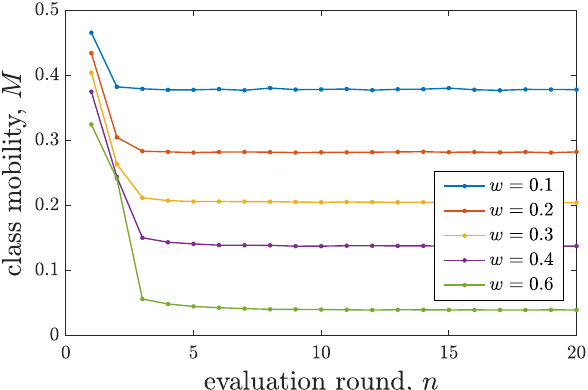
Figure 3: The class mobility M as a function of time for Case I, plotted for different values of the standard error w of the exam. M quickly approaches a steady-state value, which declines with increasing w but remains finite for all w and n